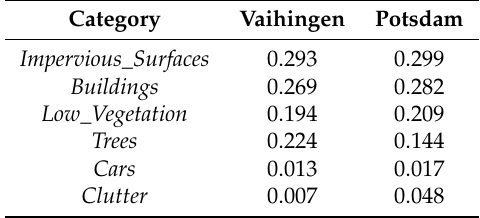
Table 1. Proportion of each semantic category in the training datasets. The proportion corresponds to the number of pixels belonging to the specific class divided by the total number of pixels in the training